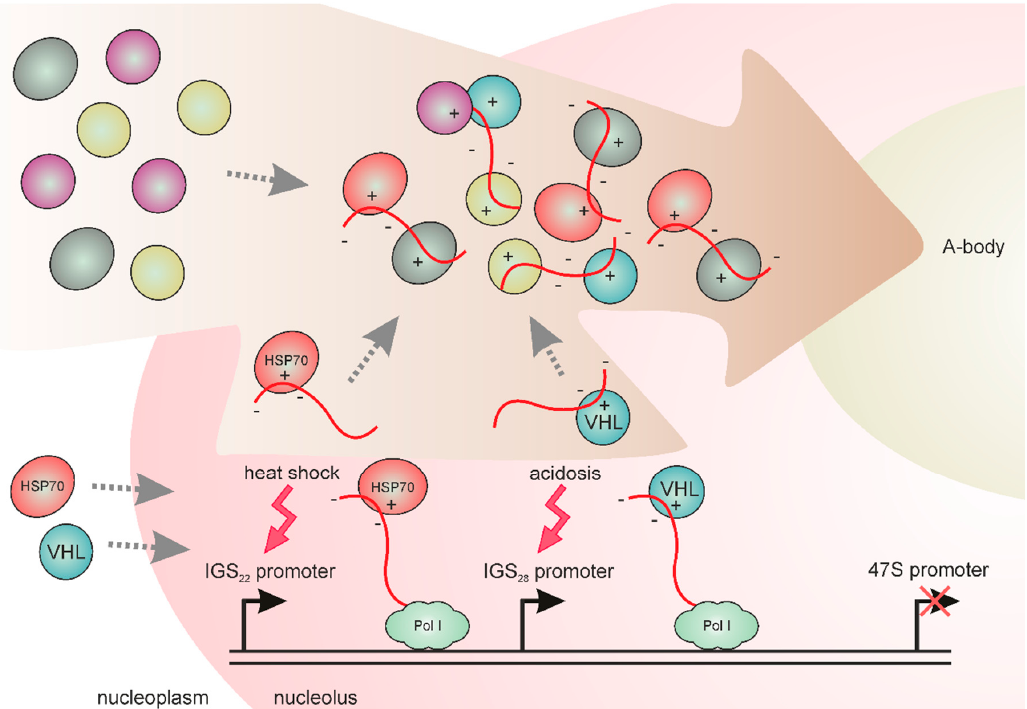
Figure 3. IGSRNAs and A-body formation in human cells. IGS 22 RNA and IGS 28 RNA are transcribed by Pol I from two distinct IGS promoters in response to heat shock and acidosis stress, respectively. These transcripts capture HSP70, VHL and many other nucleoplasmic proteins for their detention in the nucleolus. The electrostatic interactions between cationic amyloid-converting motifs of proteins and negatively charged unstructured IGSRNAs trigger formation of the solid A-body in the nucleolus.